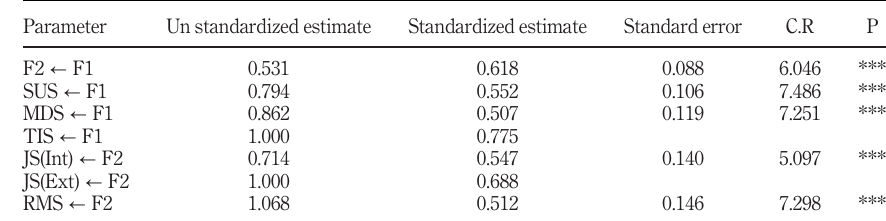
standardized and un standardized regression weights, standard error and